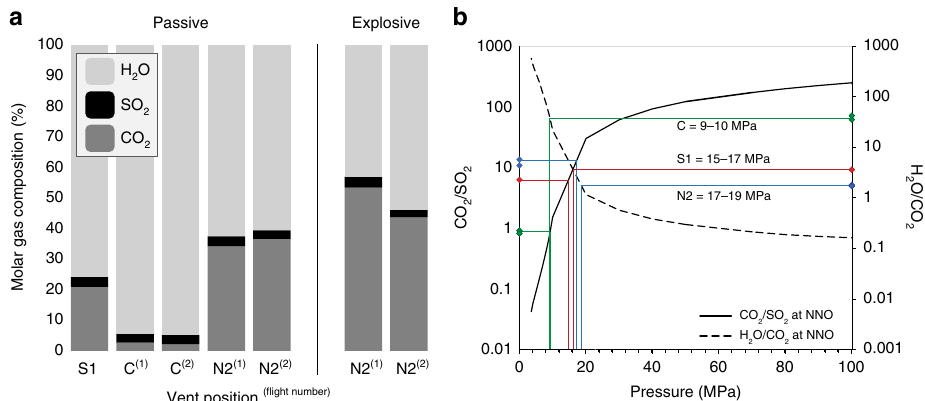
Fig. 6 Vent-speci fi c molar compositions and degassing pressures model. a Summary of vent-speci fi c molar gas compositions during passive and explosive degassing. The elevated CO 2 composition of N2 compared to C and S1 is evident. The composition of explosive gas emissions from N2 indicates elevated CO 2 composition relative to the preceding and/or succeeding passive emissions in the same fl ight. b Degassing pressures: Measured passive/ non-explosive gas compositions superposed on modelled gas compositions, expressed as CO 2 /SO 2 (solid line) and H 2 O/CO 2 (dashed line) during closed system degassing from 100 to 0.1 MPa buffered at NNO (nickel – nickel oxide redox buffer). See methods for details of model starting composition. Increasing equilibrium pressures (i.e. shallower depths of degassing) are observed from C to S1 to N2.